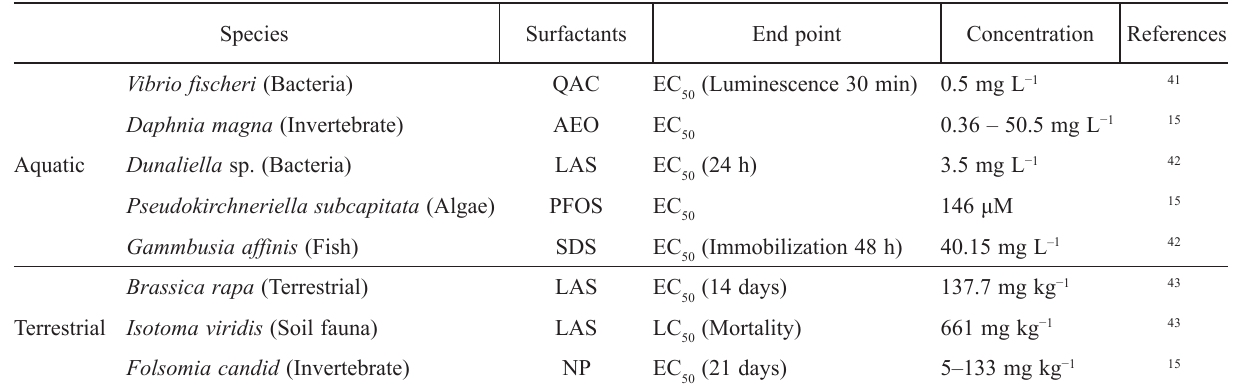
Table 2 – Toxicity of different types of surfactants to various aquatic and terrestrial species